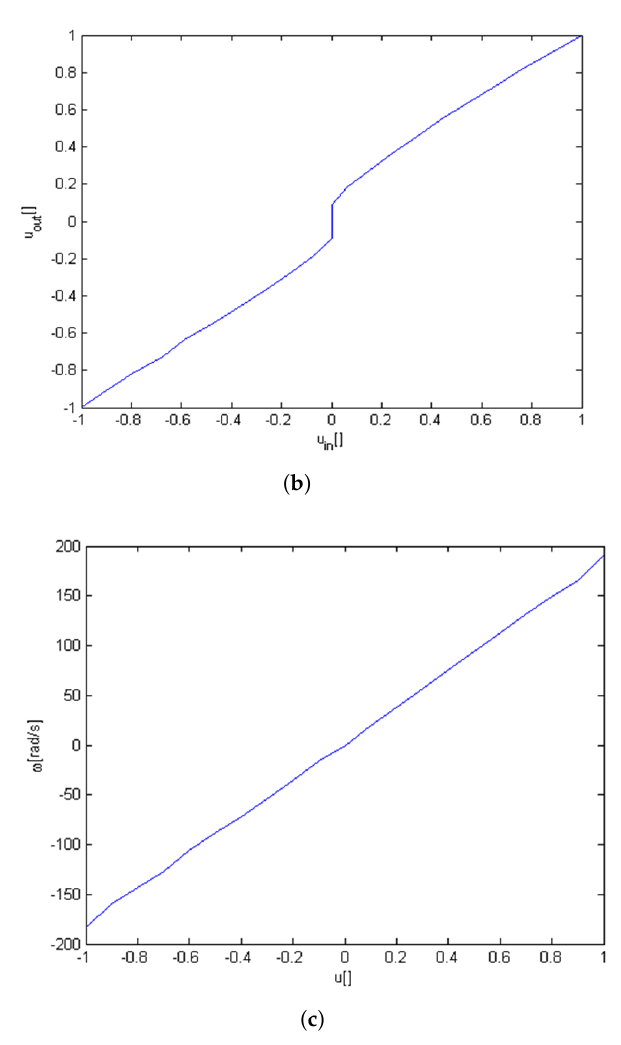
Figure 2. Linearization of the static characteristics of the plant. ( a ) Static characteristic of a servo drive; ( b ) Static characteristic of the compensator; ( c ) Final static characteristic of the linearized